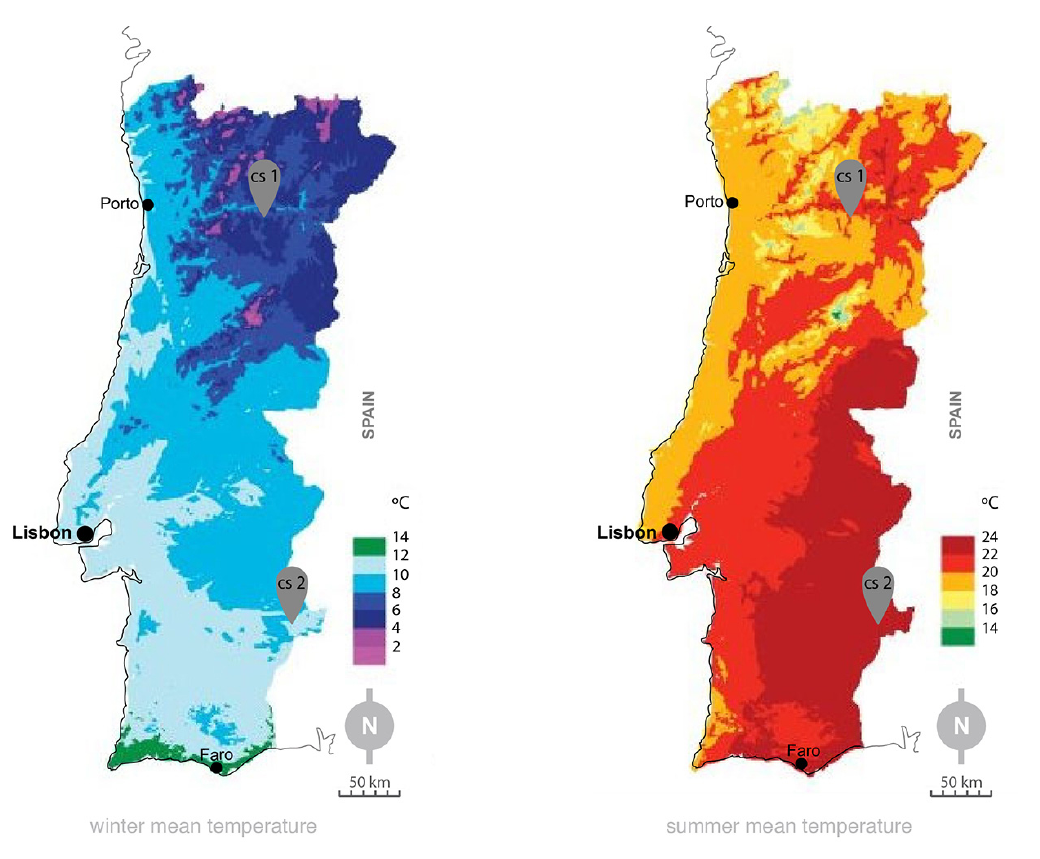
Figure 1. Winter/summer mean air temperature maps [24] and location of the case